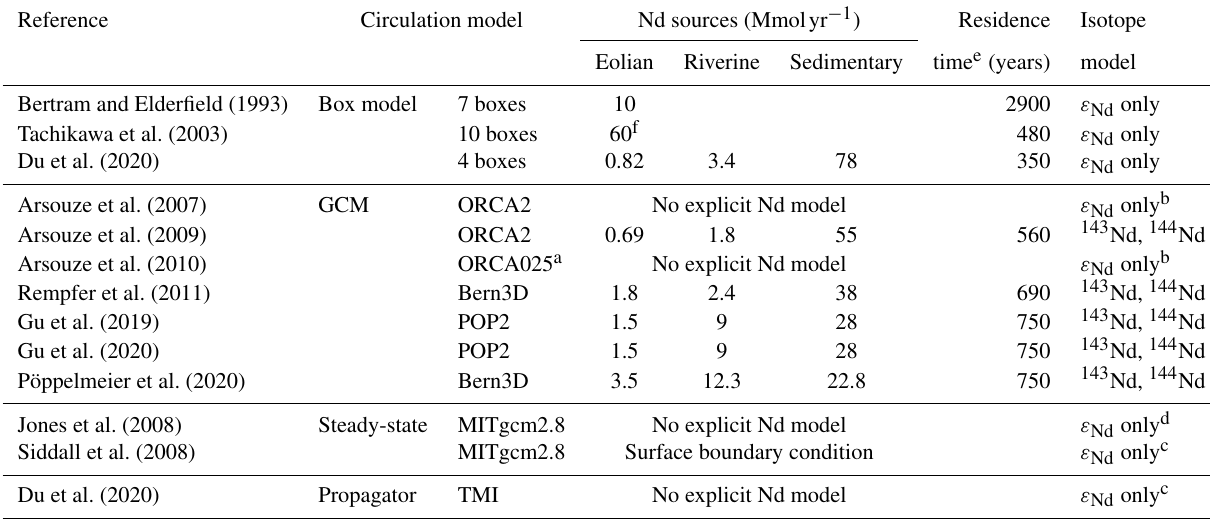
Table 1. Previous modeling studies. Note: GCM is general circulation model, and TMI is total matrix